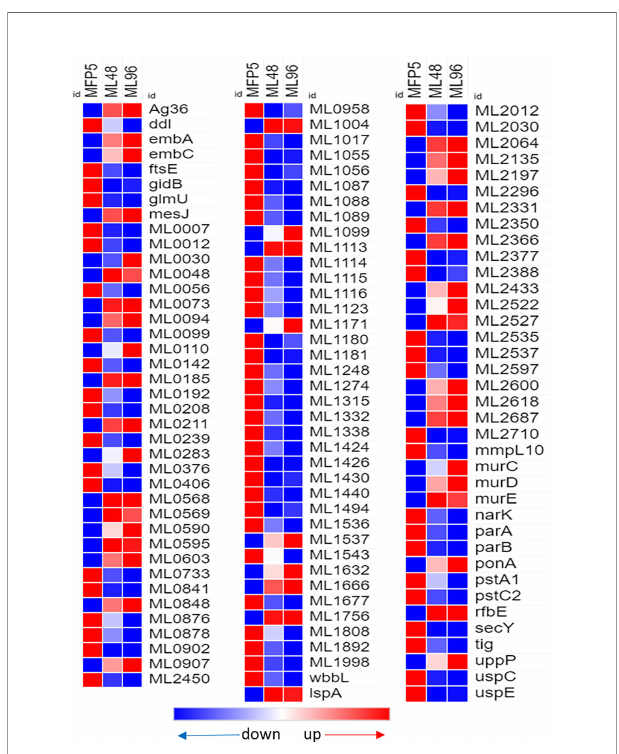
FIGURE 5 | Differential expression (average abundance) of M. leprae genes, considered to be in the cell wall and cell wall processes functional category, under in vivo (MFP5) and in vitro (ML48 & ML96) conditions. Peptidoglycan biosynthesis - https://www.genome.jp/pathway/mle00550, Lipoarabinomannan (LAM) biosynthesis - https://www.genome.jp/pathway/ mle00571, Arabinogalactan biosynthesis - https://www.genome.jp/pathway/